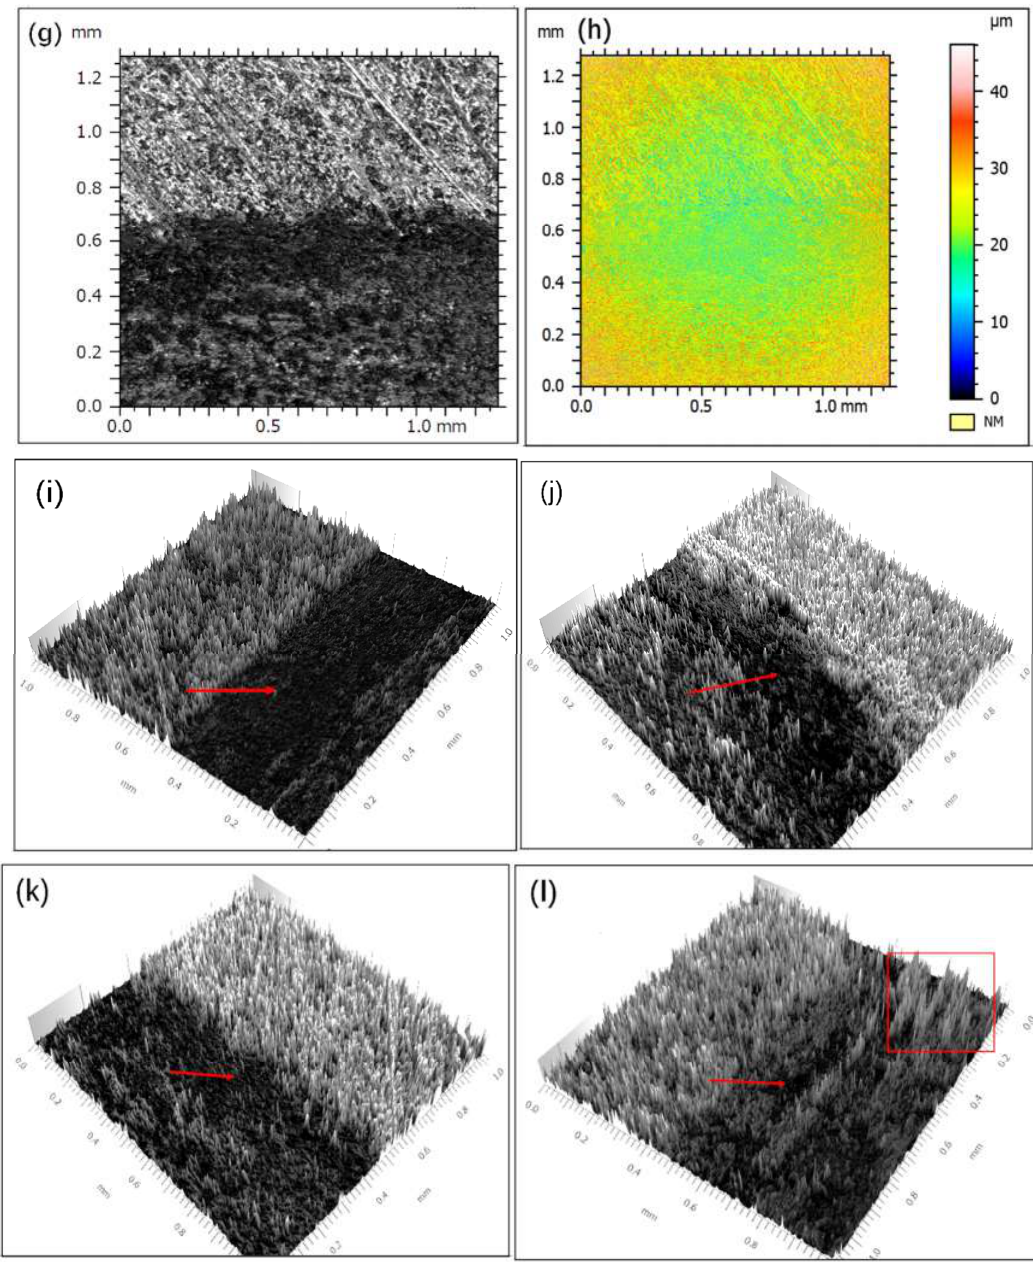
Figure 8. Confocal microscope images of Mo-Si-B alloy doped with 0.3 wt % La 2 O 3 : ( a , b , i ) 10Si-7B, ( c , d , j ) 12Si-8.5B, ( e , f , k ) 14Si-9.8B, and ( g , h , l ) 25Si-8.5B.